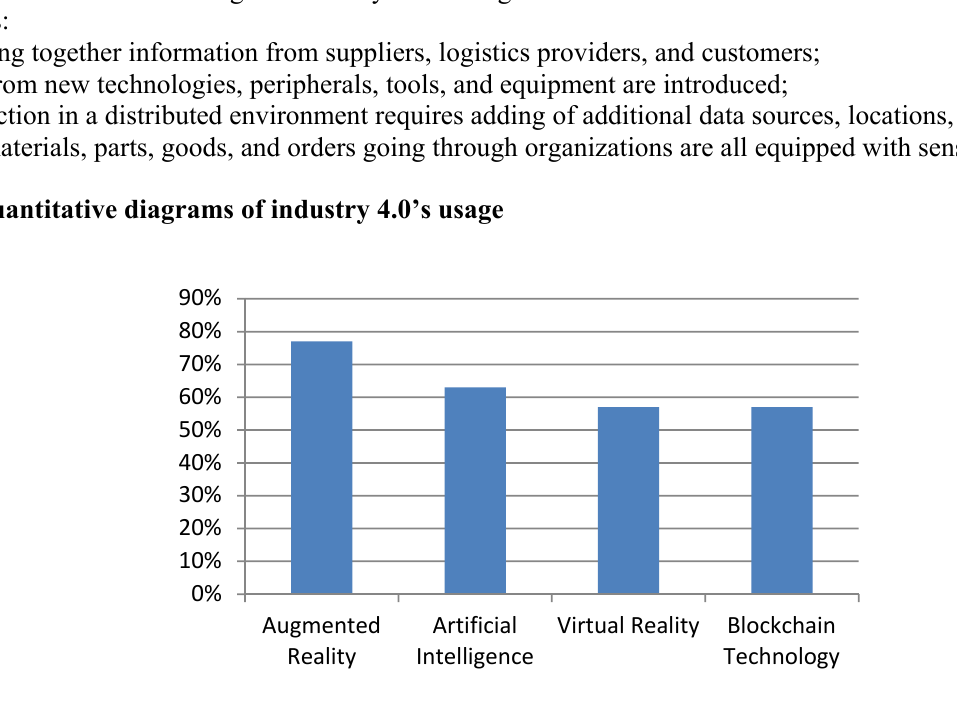
Figure 11. Usage of Industry 4.0 technologies and features by Aerospace and Defense companies in 2017